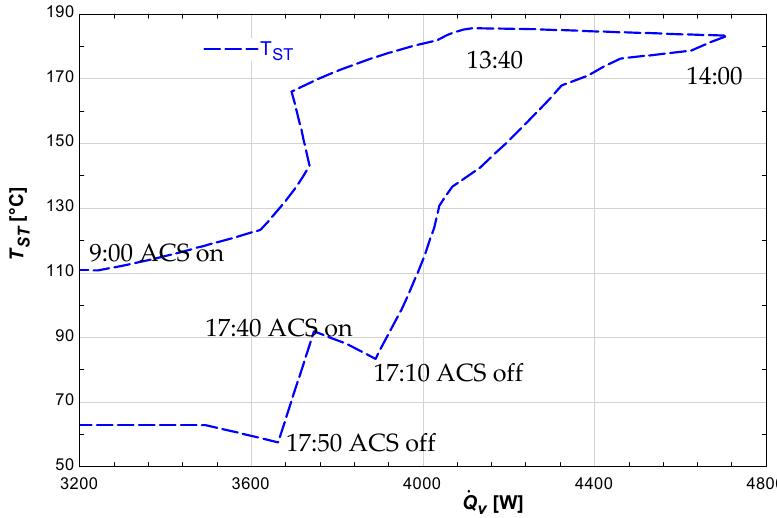
Figure 11. Cooling load influence on the storage tank fluid temperature along the day; case study 9.8 m PTC, 0.16 m 3 water storage tank.